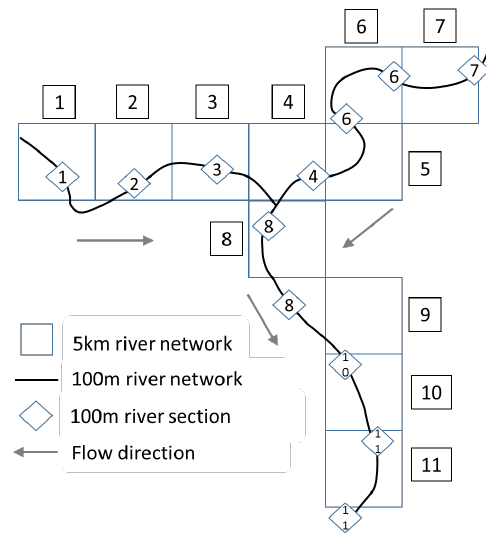
Figure 2. Conceptual scheme of the EFAS river network (5km, squares) with the high-resolution network (100m) and river sec- tions (diamonds) where flood simulations are derived. The related sections of the two networks are indicated by the same number. Adapted from Dottori et al.